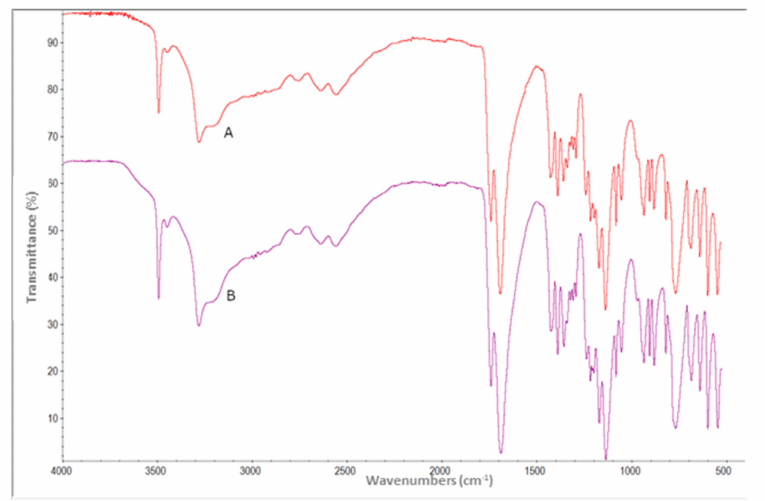
Figure 3. Infrared spectra of BioAKT Endo ( A ) and BioAKT ( B